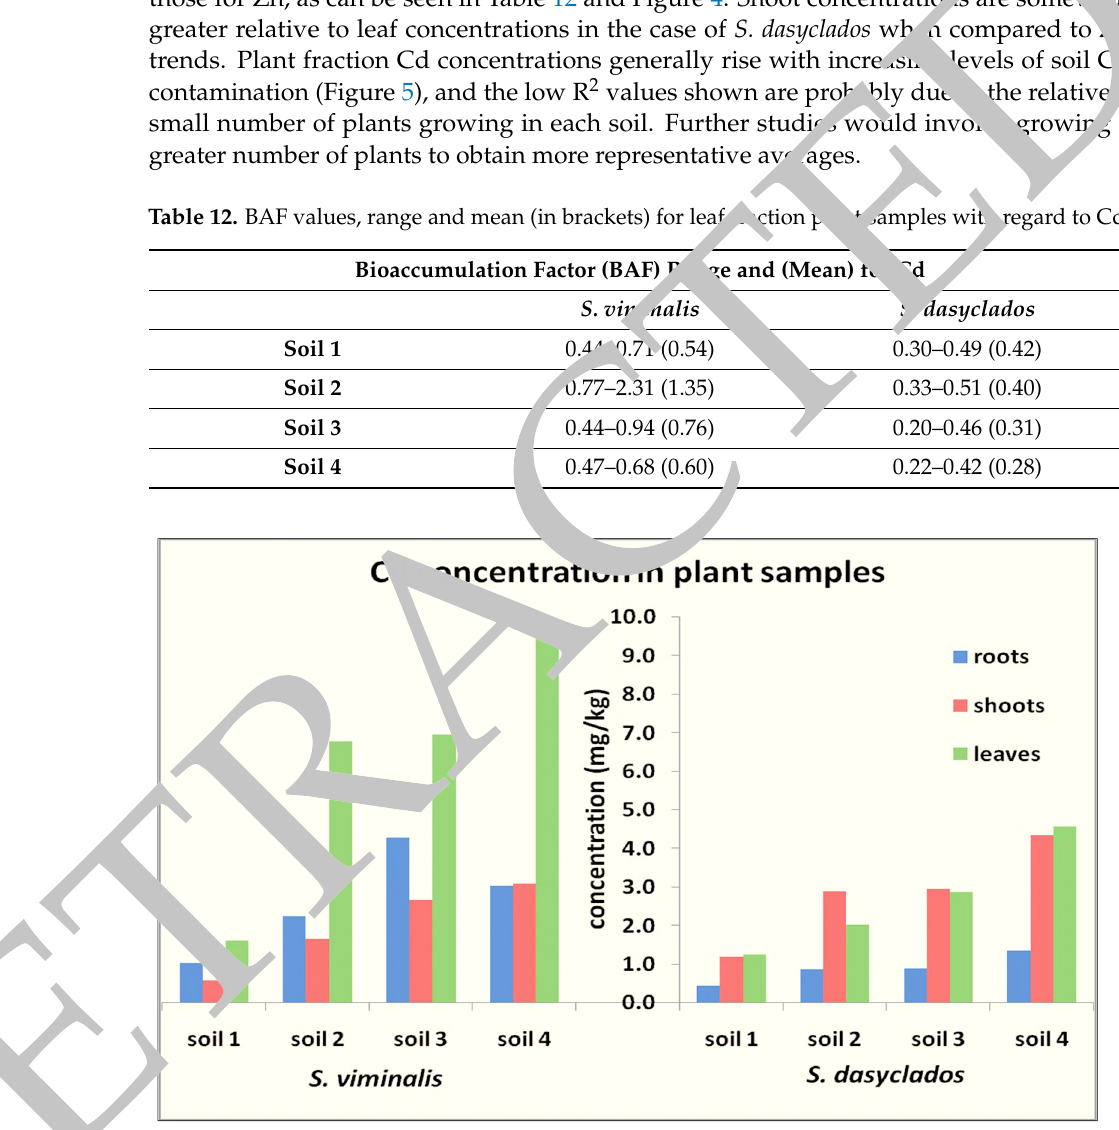
Figure 4. Mean plant fraction Cd concentrations as a function of soil contamination level showing trendline equations and R 2 values for S. dasyclados ( right ) and S. viminalis ( left